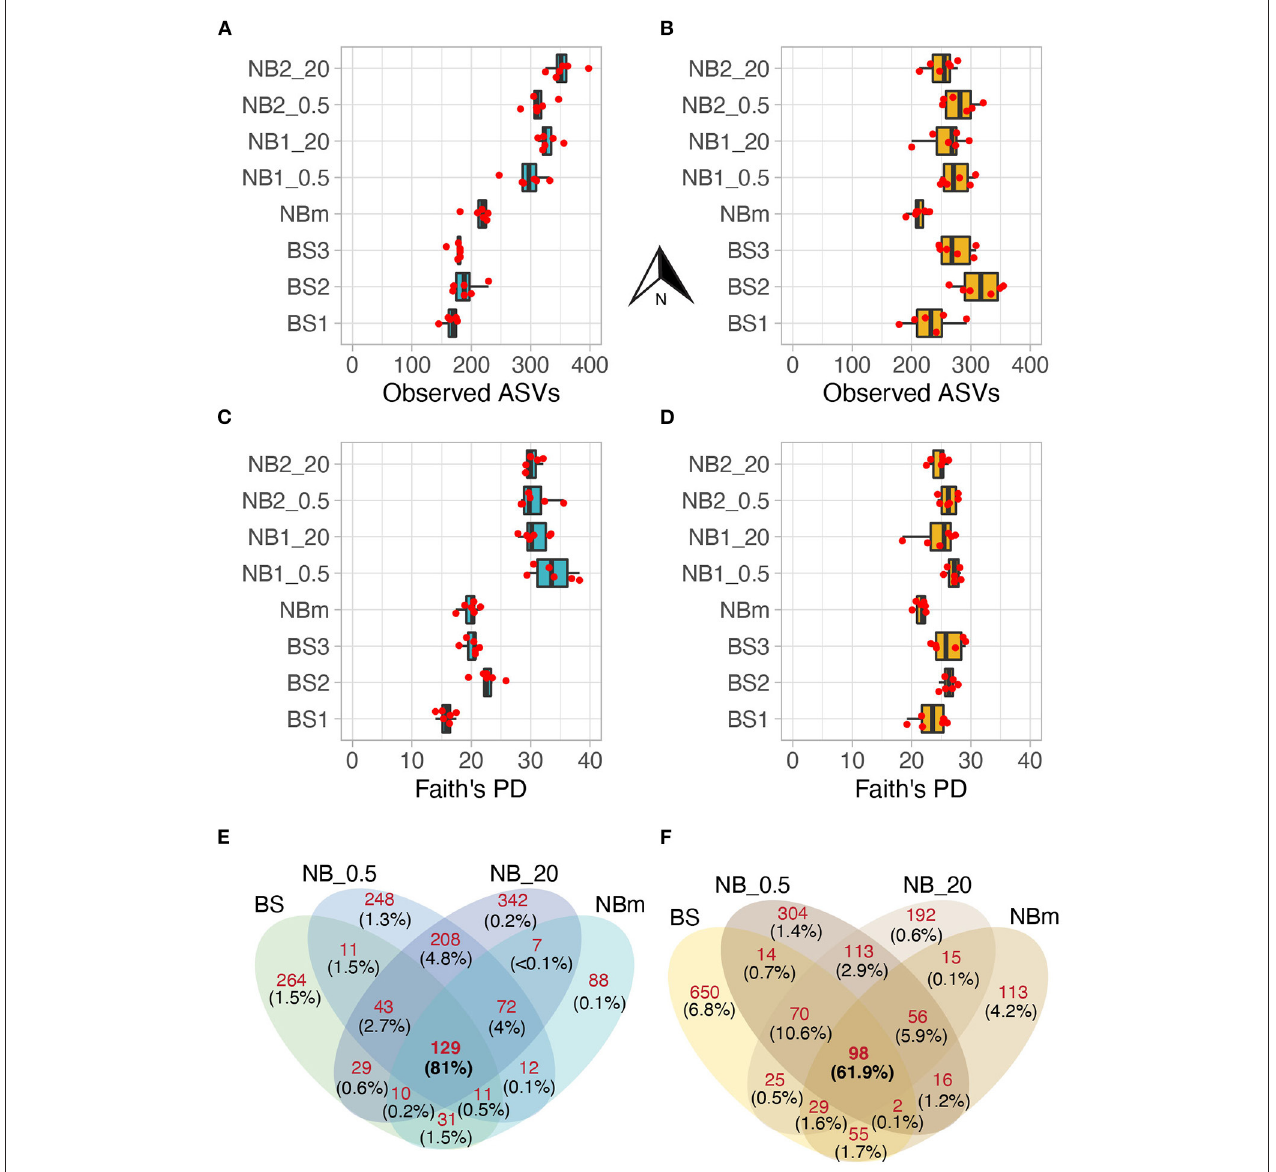
FIGURE 4 | The prokaryotic (A) and microeukaryotic (B) richness were measured as the observed number of ASVs. Corresponding Faith’s Phylogenetic Diversity (PD) values for prokaryotes (C) and microeukaryotes (D) . The values of biological replicates ( n = 6) are shown over boxplots, and the arrow denotes a northward direction of sample stations. Alpha diversity showed a distinct increasing trend along the study transect for the prokaryotic but not the eukaryotic members of the sampled microbiomes. The diversity increases with increasing Faith’s PD. Venn diagrams reporting a number of exclusive prokaryotic (E) and microeukaryotic (F) ASVs between grouped communities. Integers (shown in red color) represent the shared/exclusive number of ASVs. The relative abundance as a proportion of sequences of these ASVs from a total number of sequences is shown in parenthesis (black color). The ASVs shared by all grouped communities comprised the majority of total sequences per 16S and 18S data set. For example, (F) 129 ASVs shared by all grouped communities have high relative abundance as these ASVs comprised 81% of all sequences in the 16S dataset, whereas 264 ASVs exclusive to BS stations accounted for only 1.5% of a total number of sequences in the same